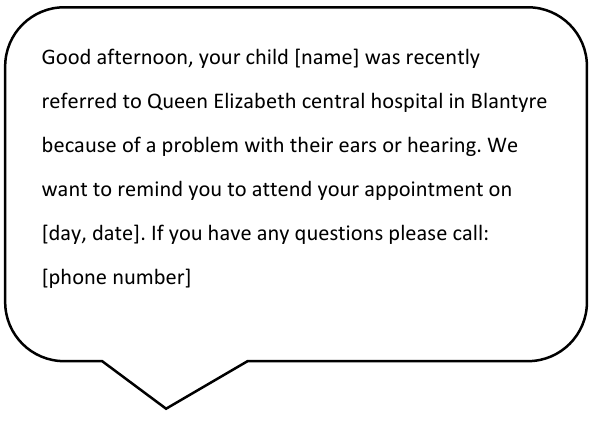
Figure 3. Text message reminder (English version).